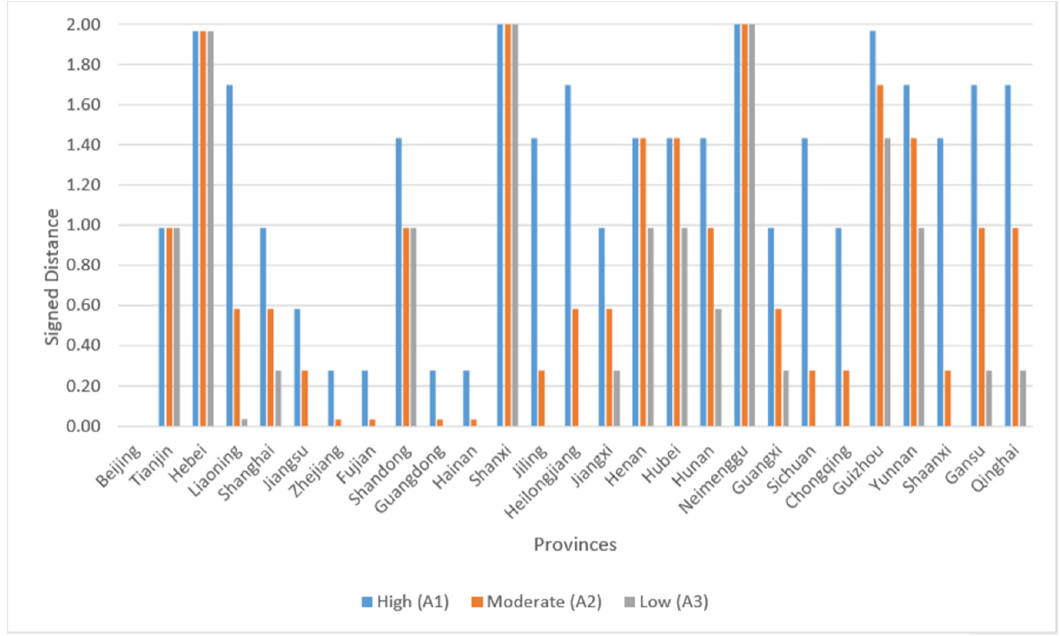
(cid:17) (cid:16) 0(cid:3560) A ij , (cid:101) 0 1 ) . . (cid:2869)